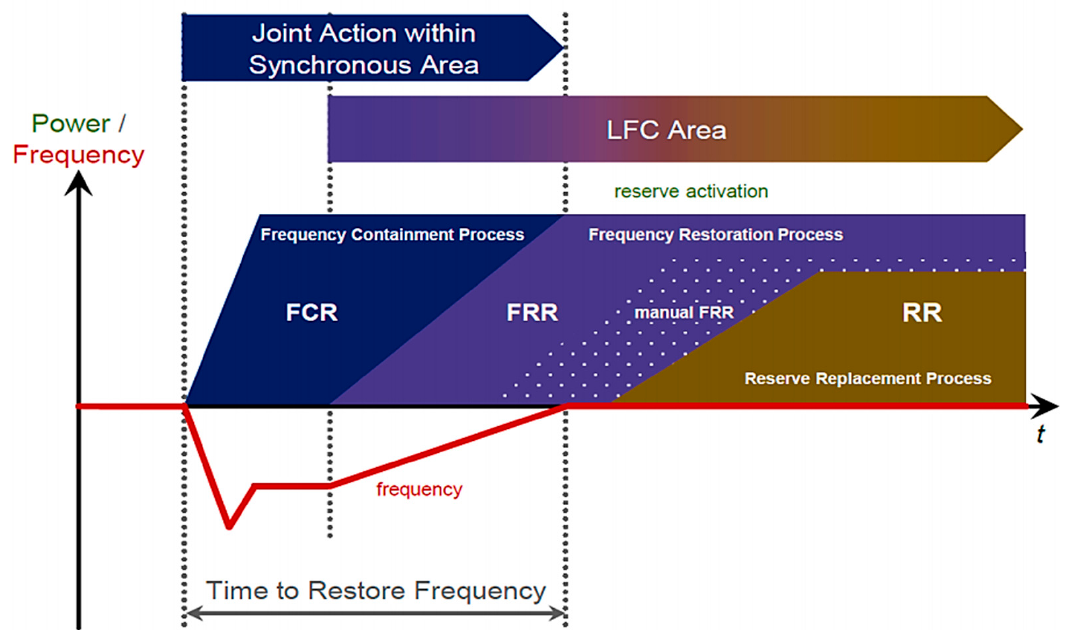
Figure 3. The harmonized sequence of balancing processes for full frequency restoration [33]. LFC: load frequency control, FRR: frequency restoration reserve, and RR: regulating region.